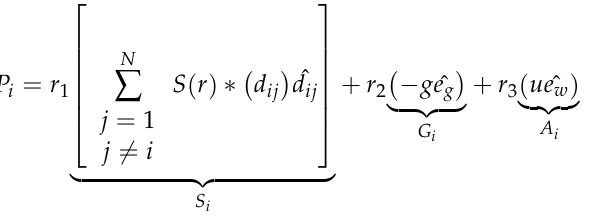
The social interaction of grasshoppers is highly dependent on their social force and the distance between them. The social force ( S ( r ) ) is calculated as per (5), where f is the attraction intensity and l is the attractive length scale. The S ( r ) governs the social attraction and repulsion (or exploitation and exploration) of the grasshoppers. If f and l vary in the interval [0, 2.079] repulsion will occur and if f and l vary in the interval [2.079, 4] attraction will happen in grasshoppers. The grasshopper will be in its comfort zone when f and l remain exactly at 2.079. The d ij is the distance between i th and j th grasshopper and ˆ d ij is a unit vector showing the direction of the grasshopper